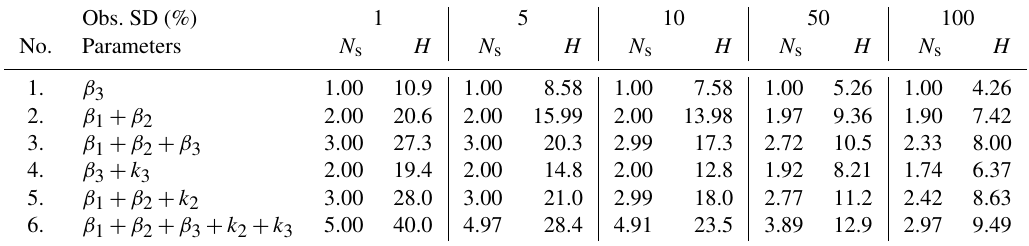
Table 2. Number of signal degrees of freedom N s and reduction in entropy H as a function of observation standard deviation, taken from the lowest model layer (closest to the surface). Results are shown for different subsets of k 1 , k 2 , β 1 , β 2 , β 3 , where k i and β i represent the extinction and backscattering coefficient, respectively, at the wavelengths λ 1 = 1064nm, λ 2 = 532nm, and λ 3 = 355nm. Obs. SD (%) 1